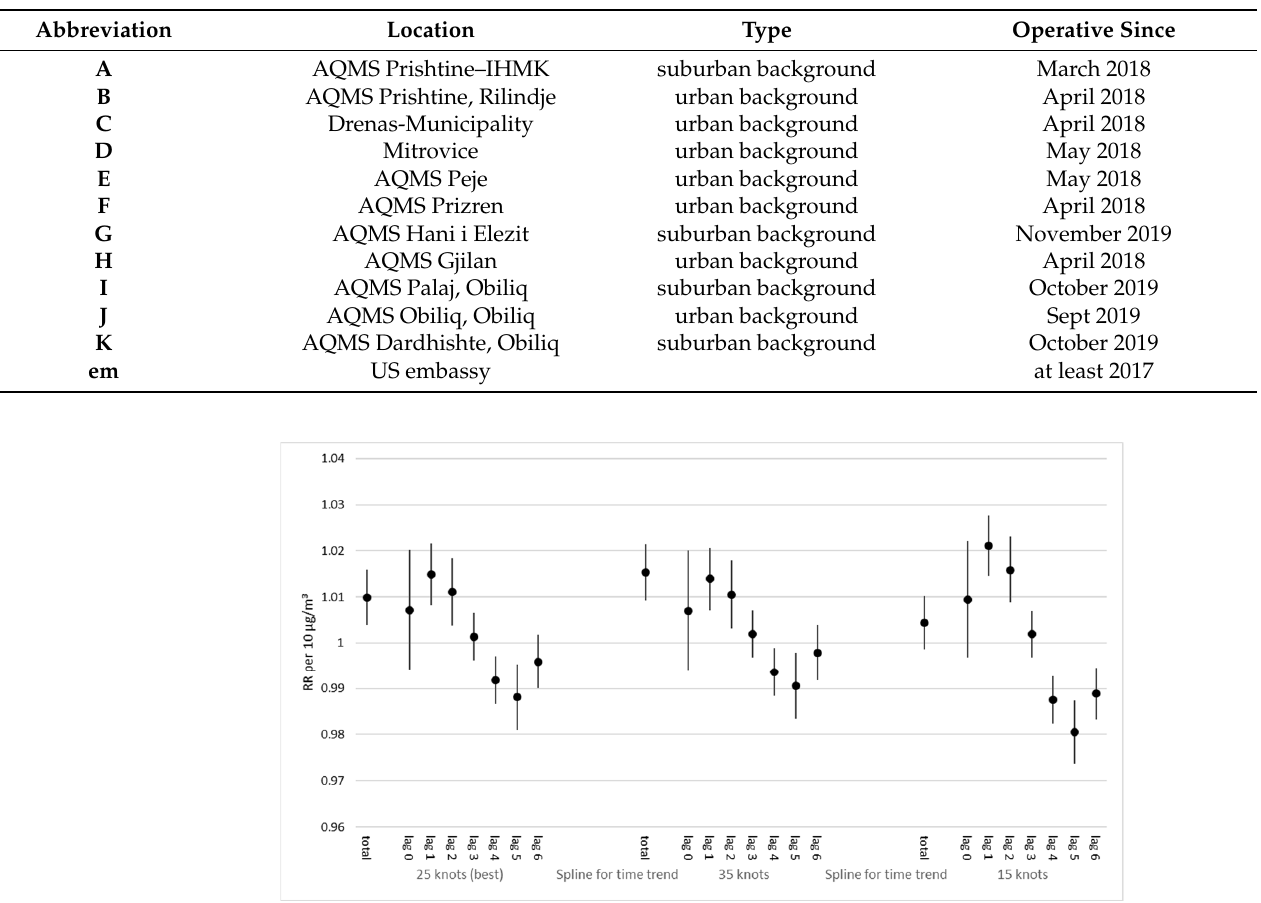
Figure A3. Sensitivity analysis: Effect (relative risk and 95% confidence interval) on stationary hos ‐ pital admissions per 10 μ g/m³ increase in PM2.5, total effect and daily effects over 10 consecutive days (lag 0–9): Optimal model (16 knots for the time smoother).